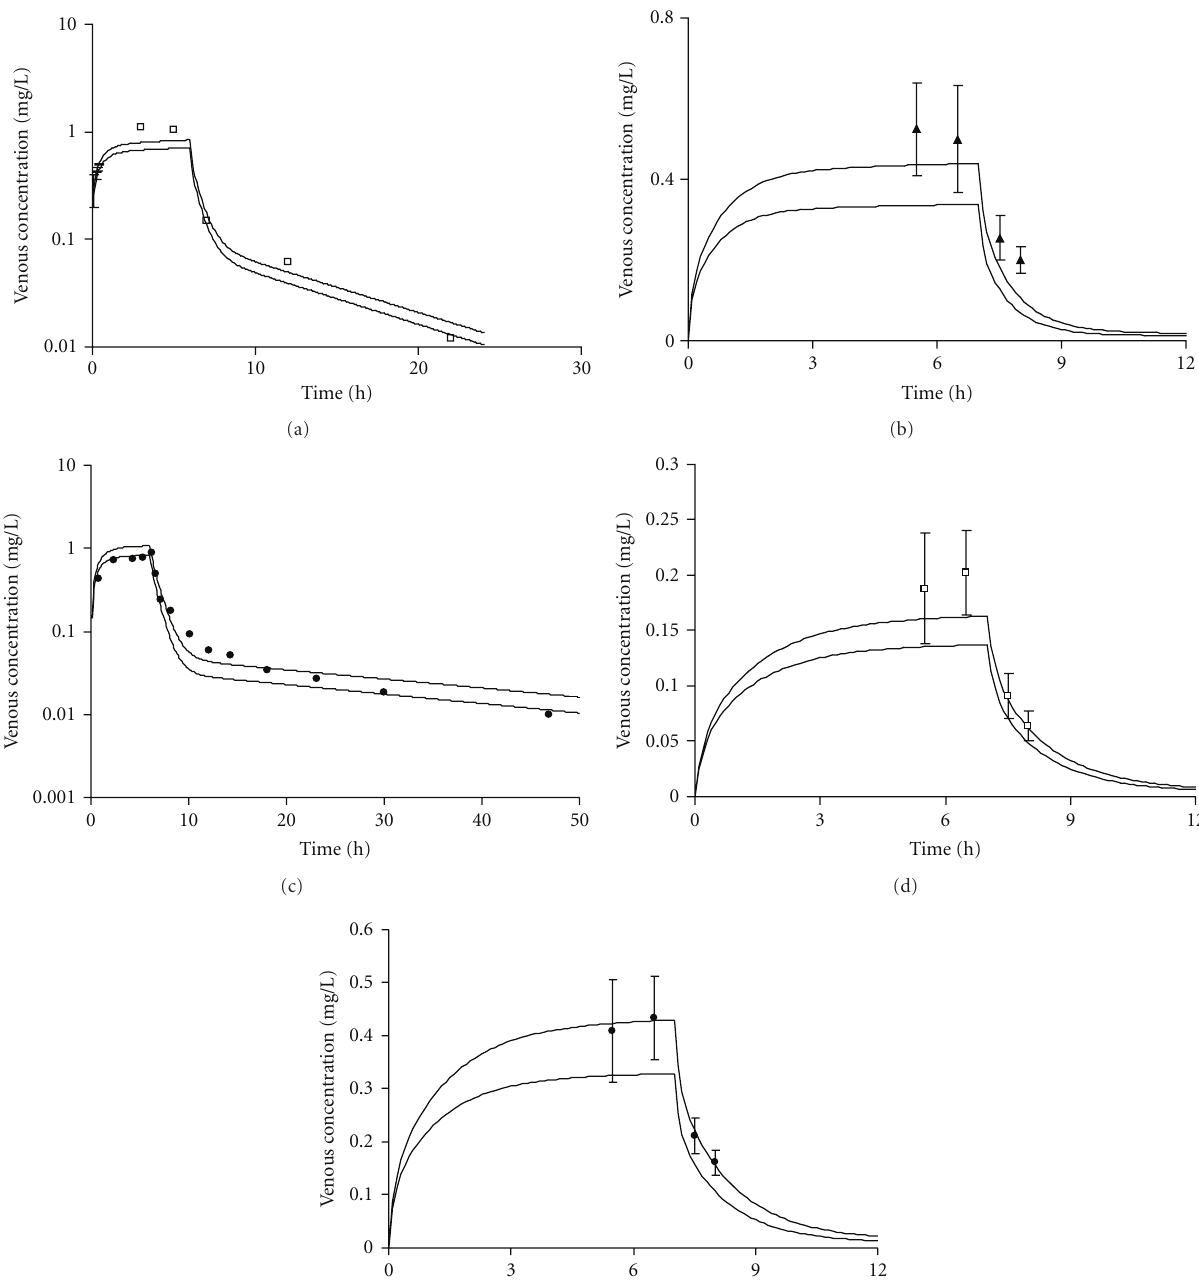
Figure 4: Comparison of PBPK model simulation with experimental data of venous blood concentration following inhalation exposure to (a) 100ppm, 6h dichloromethane [77]; (b) 33 ppm, 7 h ethylbenzene [67]; (c) 80 ppm, 6 h styrene [78]; (d) 17 ppm, 7 h toluene [67]; (e) 33ppm, 7 h m -xylene [67]. Bold lines: predicted LMCI and UMCI for CL int .